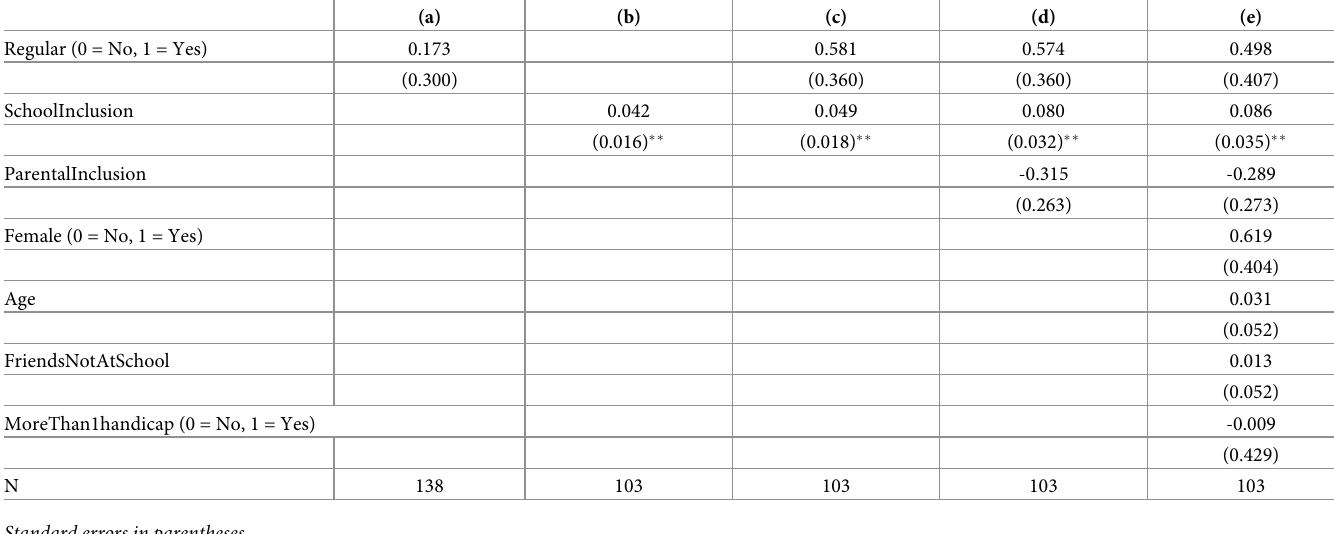
Table 3. Ordered logit regression explaining Inclusion of Other in the